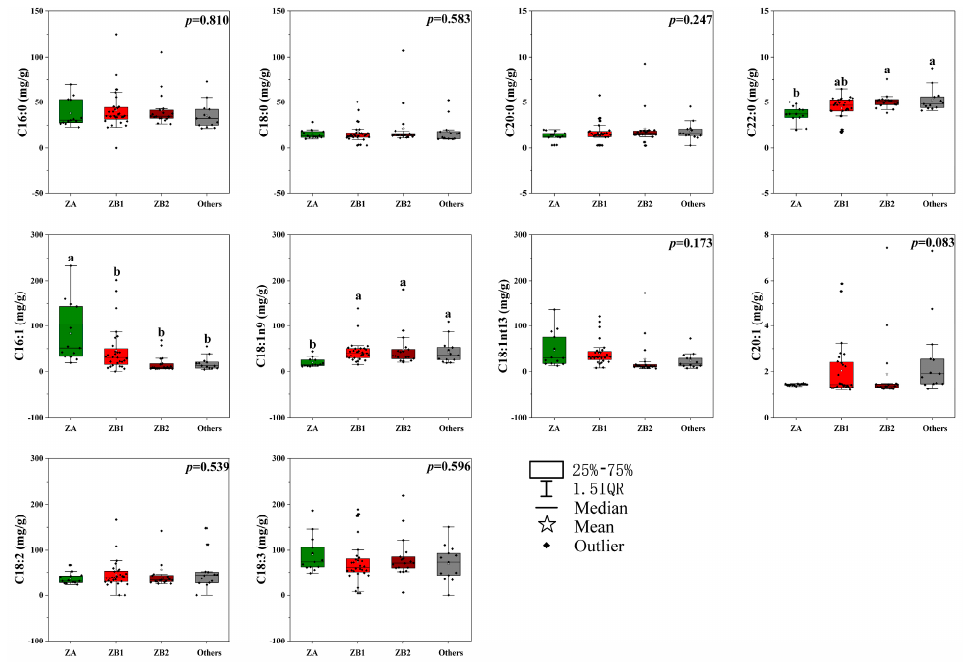
Figure 1. The fatty acid content and composition in pericarps among different Zanthoxylum groups. The different letters (a, b, or ab) above the histogram indicate significant differences among the Zanthoxylum species, and no letters above the histogram means no significant difference among different Zanthoxylum species ( p < 0.01); ZA is Z. armatum ; ZB1 samples, belonging to Z. bungeanum , are represented by pericarps from Hancheng; ZB2 samples, belonging to Z. bungeanum , are represented by pericarps from Fengxian; others refers to the rest of the samples whose pericarps are red but do not belong to Z. bungeanum ; C16:0 is palmitic acid; C18:0 is stearic acid; C20:0 is eicosanoic acid; C22:0 is behenic acid; C16:1 is palmitoleic acid; C18:1n9 is oleic acid; C18:1n13t is trans-13-oleic acid; C20:1 is cis-11-eicosenoic acid; C18:2 is linoleic acid; C18:3 is linolenic acid; and IQR is interquartile